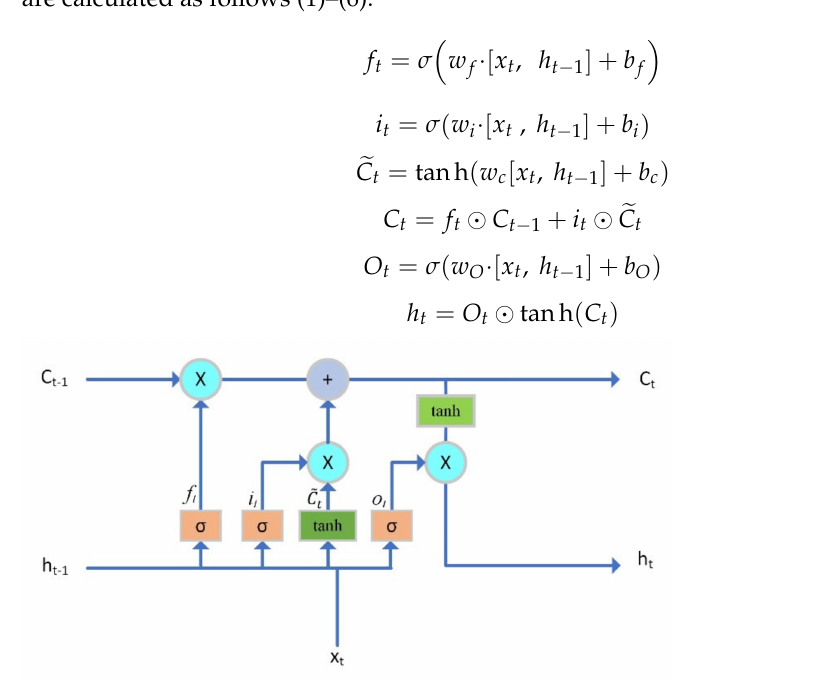
Figure 4. LSTM cell structure.